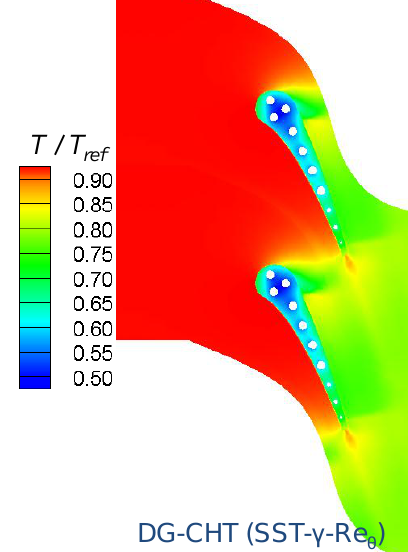
Figure 13. Computed temperature contour of Mark II (SST + γ- Re θ